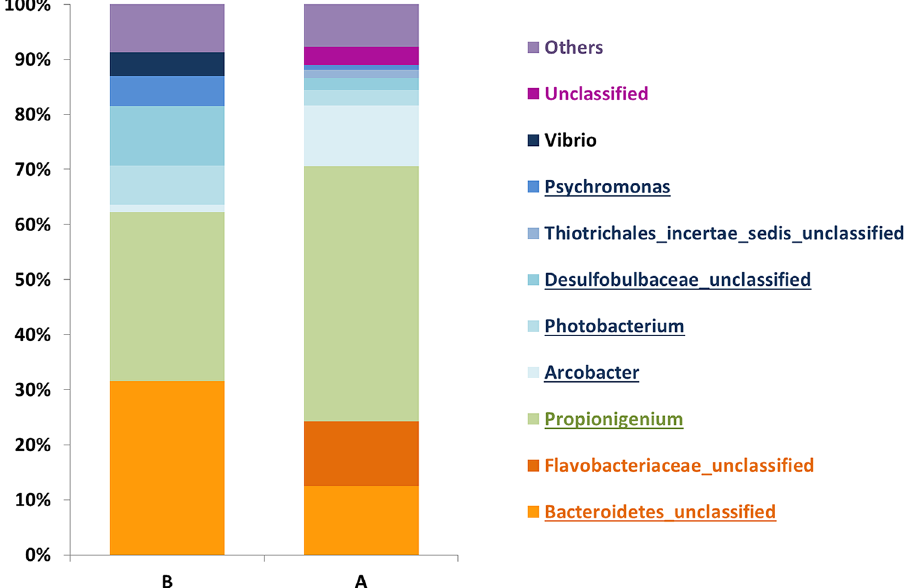
Figure 1. Mean relative abundances of taxa, at genus level, of the coelomic fluid microbiota of P. lividus individuals collected from sites A and B. The corresponding phylum is highlighted by using shades of blue, green, and orange for Proteobacteria , Fusobacteria and Bacteroidetes , respectively. All bacterial genera with relative abundance < 1% are reported together and labeled as “Others”. The underlined taxa represent the microbiota core